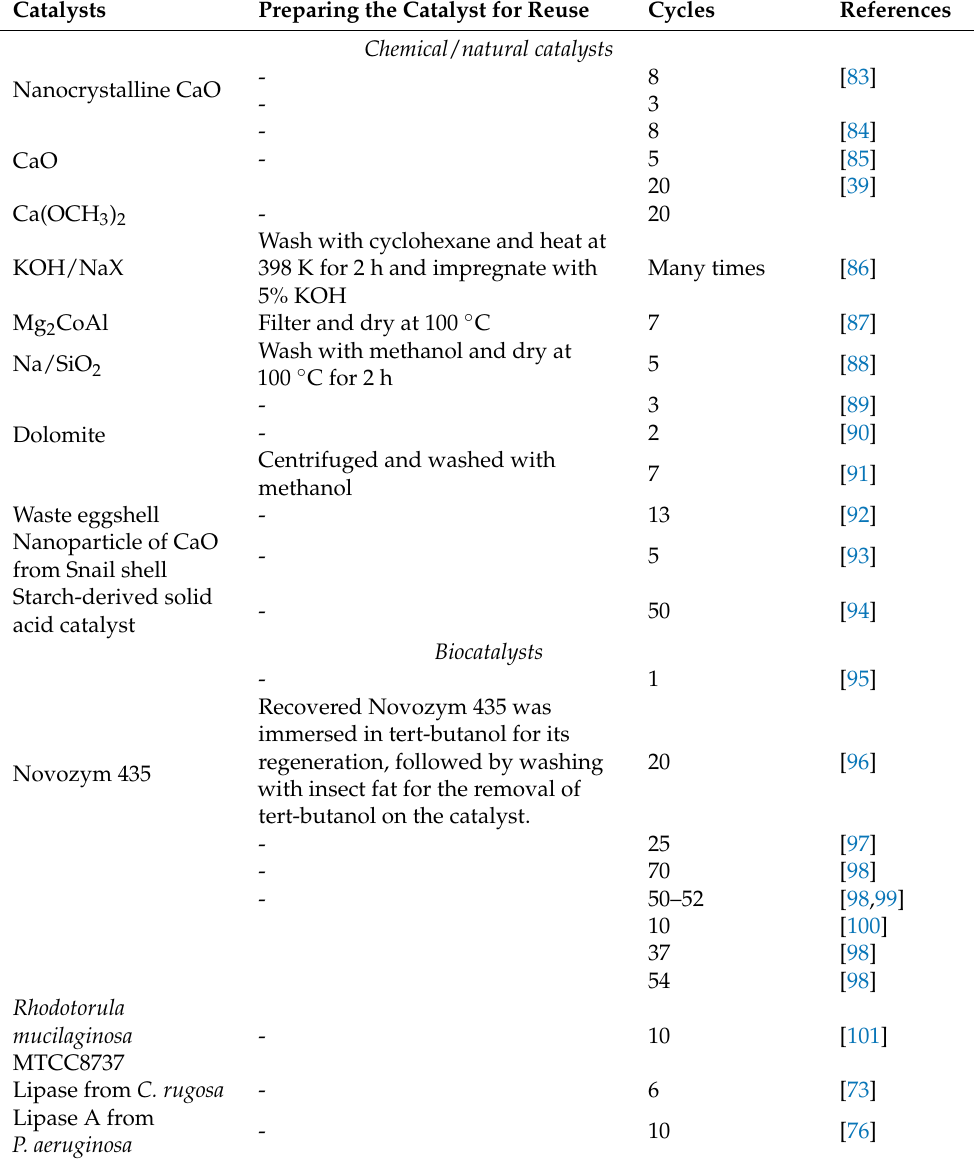
Table 8. Reuse of heterogeneous catalysts in biodiesel